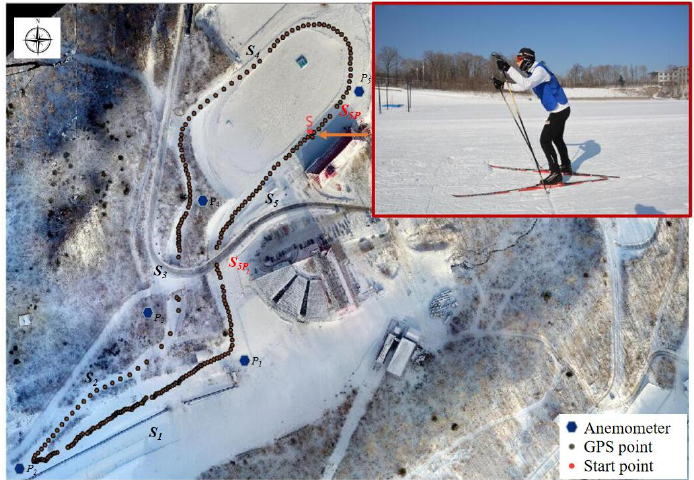
Figure 5. Racetrack division and athletes’ sliding trajectory.